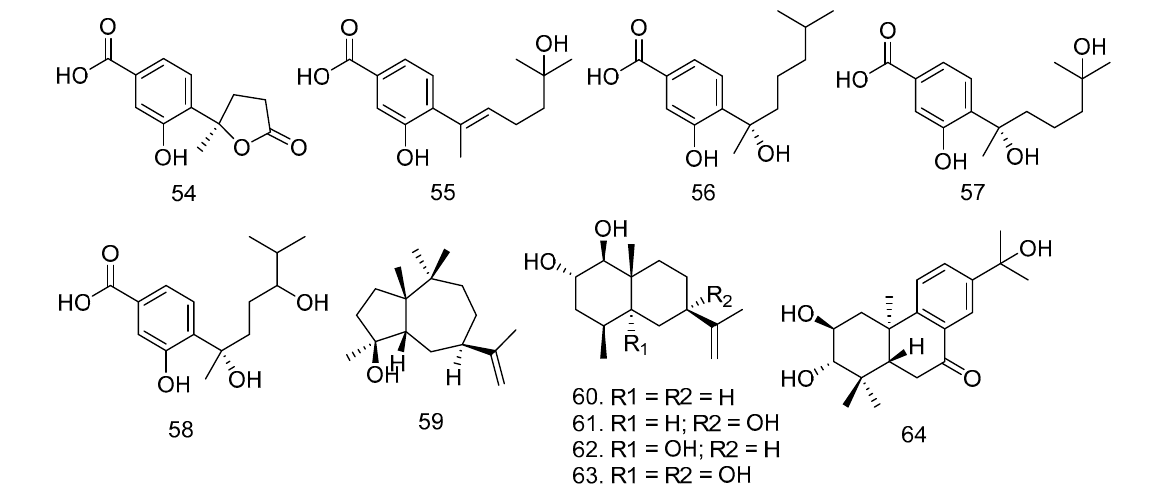
Figure 2. Triterpenoids, diterpenoids, and sesquiterpenoids were obtained from endophytic fungi isolated from the Meliaceae family.